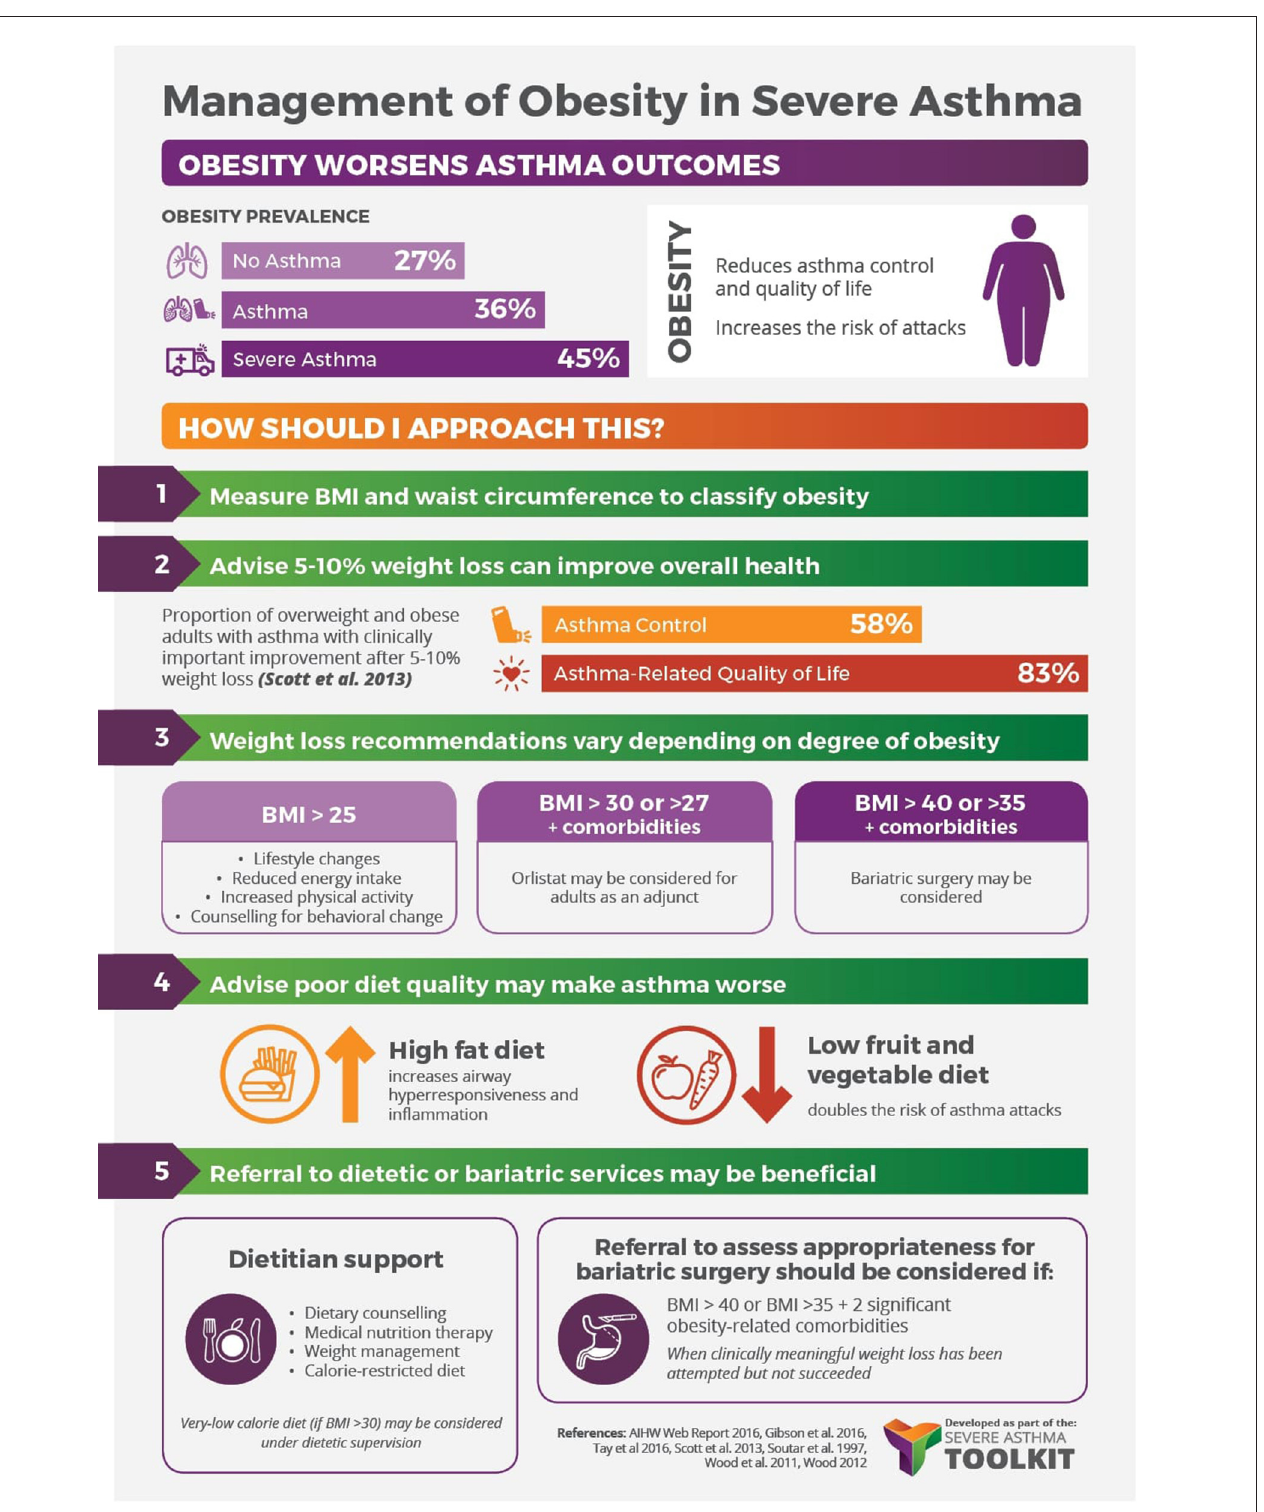
FIGURE 2 | Management of obesity in severe asthma infographic—Content has been reproduced with permission from the Centre of Excellence in Severe Asthma, originally developed as part of the Centre of Research Excellence in Severe Asthma (https://toolkit.severeasthma.org.au).